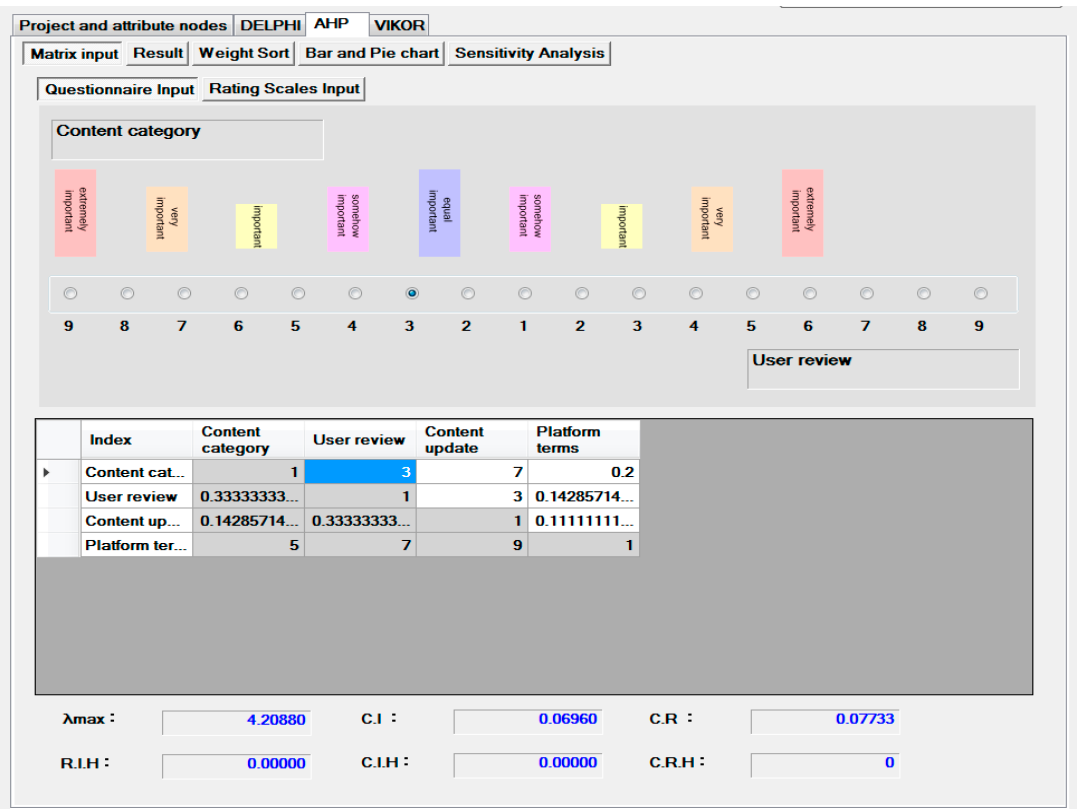
Figure A1. Processing of Power Choice v2.5 of the Analytic Hierarchy Process (AHP) questionnaire.